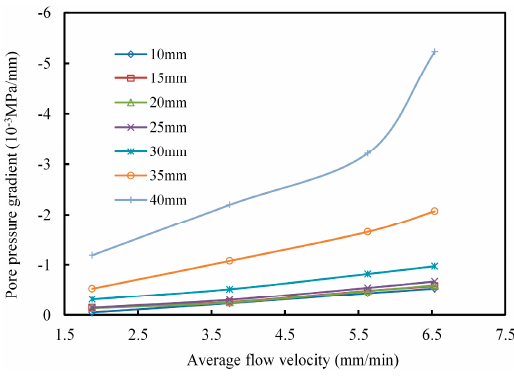
Figure 10. Relation of pore pressure gradient with flow velocity for the uniform sample.